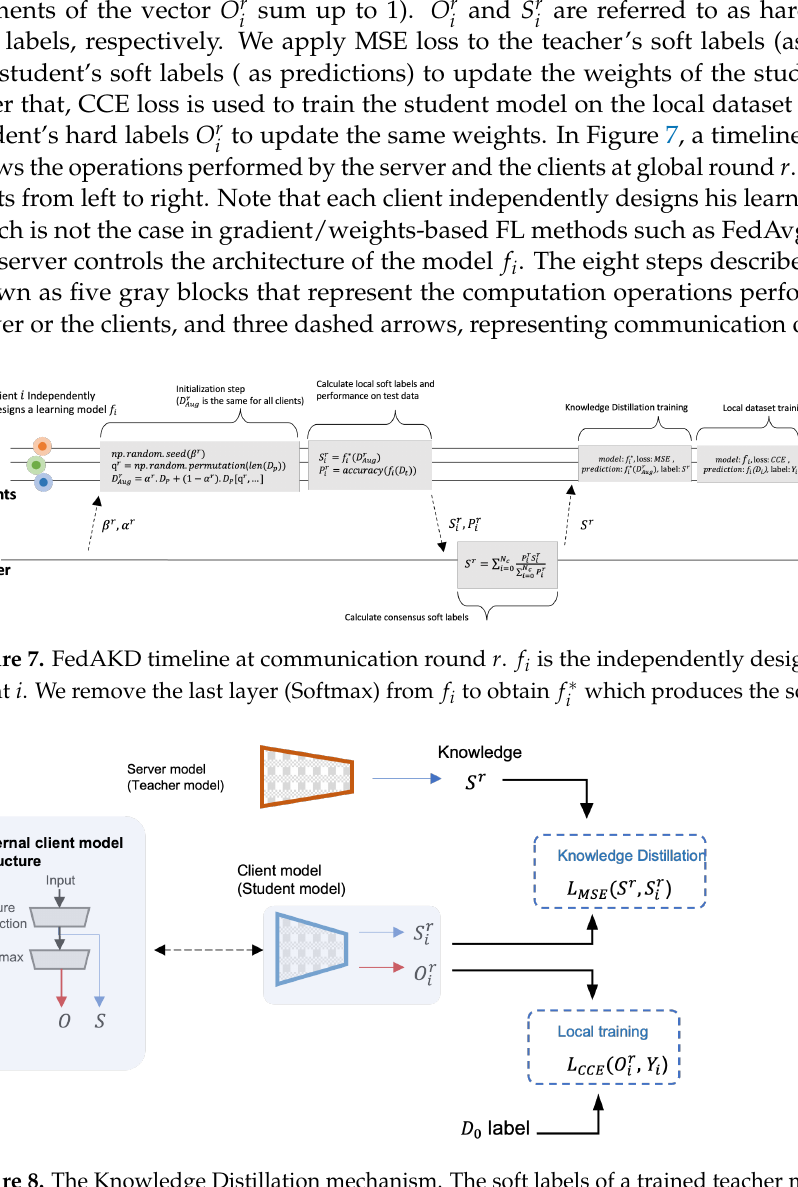
Figure 8. The Knowledge Distillation mechanism. The soft labels of a trained teacher model are used to distill knowledge to a student